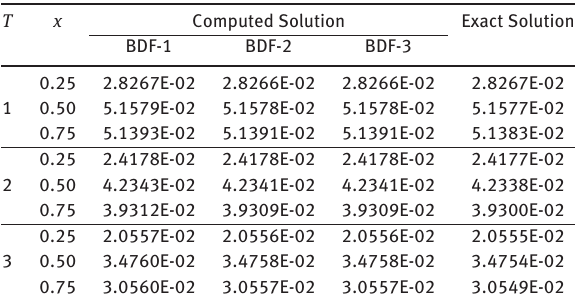
Table 14: Comparison with different numerical methods and